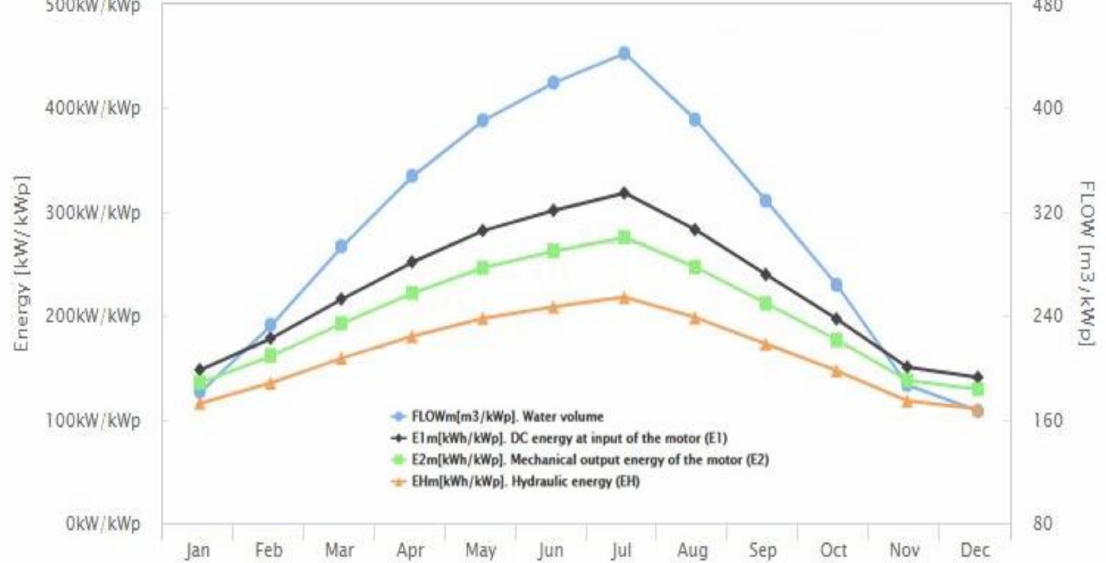
Figure 15. The global performances of the PV pumping system for Antalya,